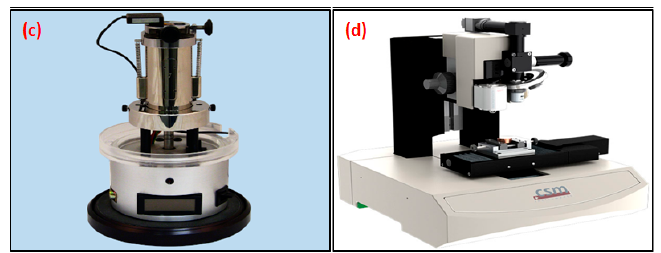
Figure 2. Commercial representative indentation instruments: ( a ) Nano-Indenter XP (Keysight Technologies); ( b ) Ultra-Micro-Indentation System (IBIS); ( c ) TS-75-TriboScope (Hysitron); ( d ) Table-Topnanoindentation (Anton Paar).